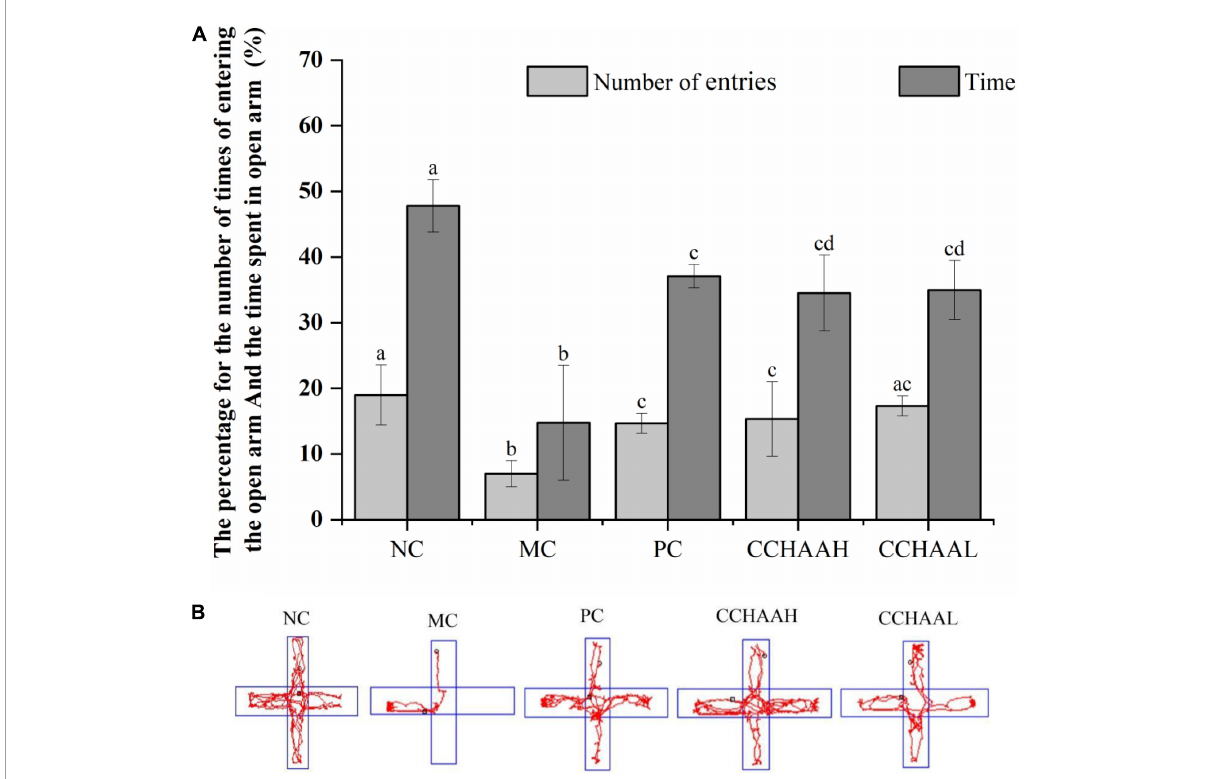
FIGURE1 (A) The effects of CCHAA formula on the behaviors of mice in the elevated plus-maze test. Different letters indicate significant differences ( P < 0.05). (B) The total movement tacked in EPM test: The red lines were the recorded motion tracks/routes of mice. The arms in the vertical direction were the closed arms, and those in the horizontal direction were the open